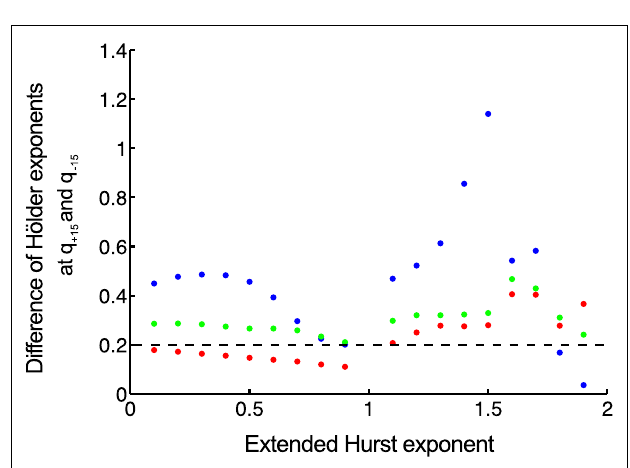
FIGURE 7 | Separating monofractals from multifractals. ∆ h values obtained by MF-DFA (as difference of Hölder exponents at q =+ 15 and q =− 15) are shown for monofractals with length of 2 10 (blue), 2 12 (green), 2 14 (red). It is clearly shown that longer signals are characterized by lower ∆ h , and its value below 0.2 means that true multifractality is unlikely present (Grech and Pamula, 2012). Signals were created by DHM at extended Hurst exponents of 0–1.9 with a step of